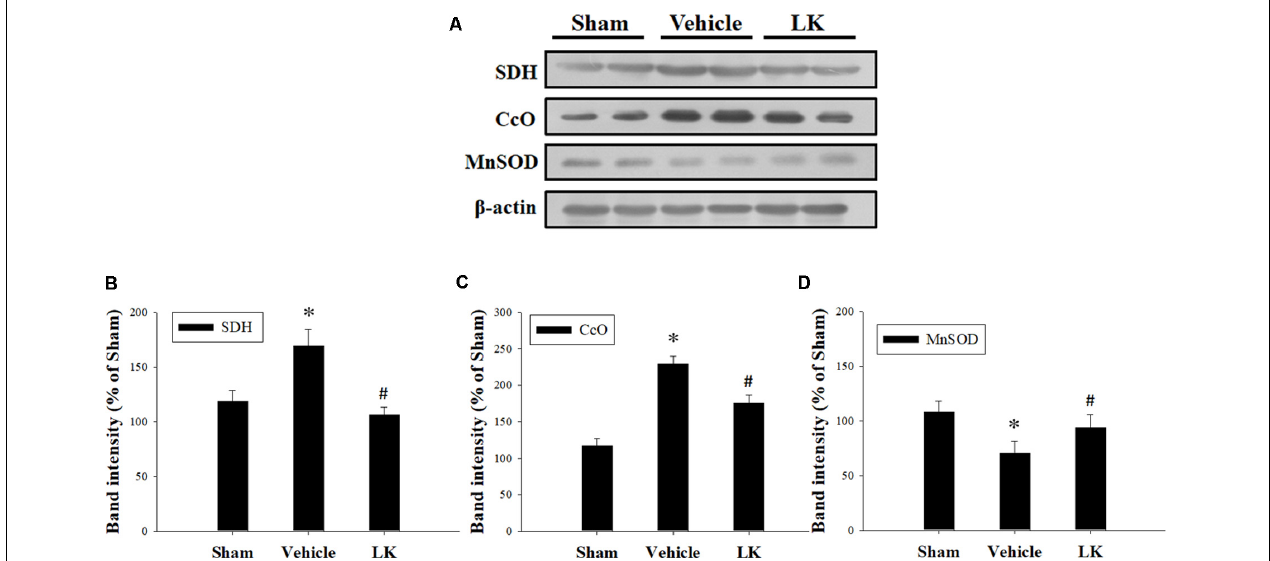
FIGURE 3 | Post-ischemic lumbrokinase treatment reduced mitochondrial oxidative stress induced by myocardial I-R injury. (A) Representative images of the Western blot results. Quantitative densitometric analysis of (B) SDH, (C) CcO, and (D) MnSOD protein expression in rat myocardium after myocardial I-R injury. Data are normalized with values from the sham group and presented as percentage rates. Each value is represented as the mean ± SEM ( n = 3). ∗ p < 0.05 compared with the sham group; # p < 0.05 compared with the vehicle group.